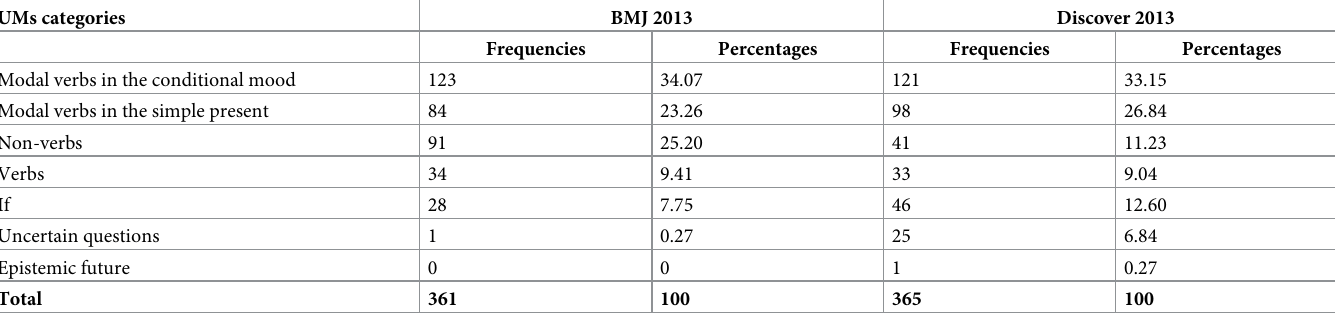
Table 20. Frequencies and percentages of UMs in BMJ 2013 and Discover